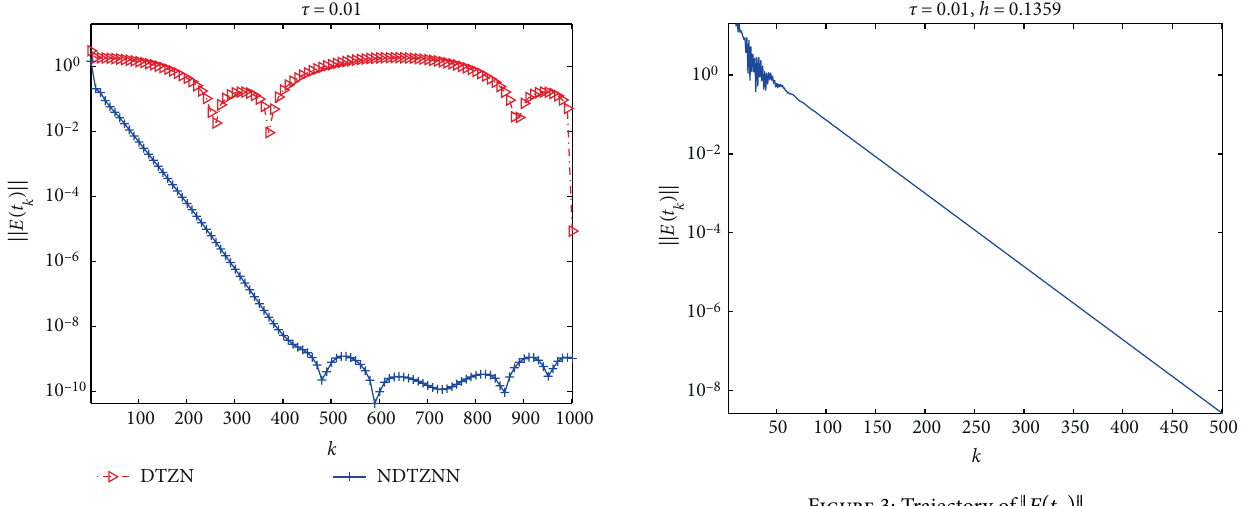
Figure 3: Trajectory